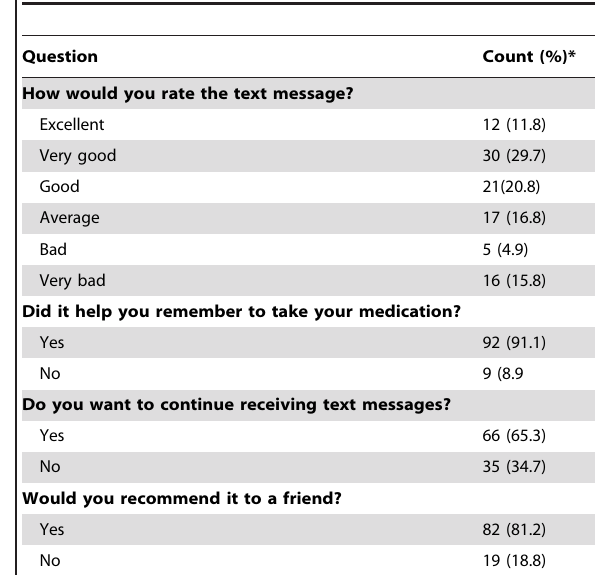
Table 4. Satisfaction with the text message among the participants who received text messages (n=101).